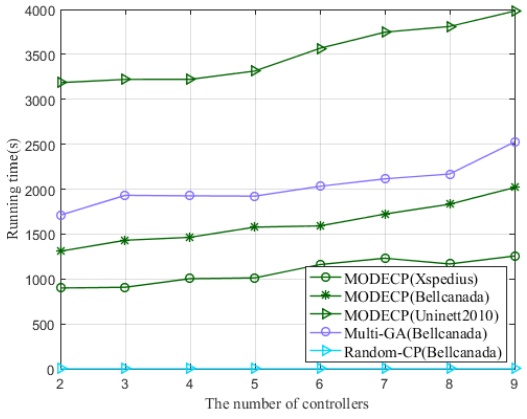
Figure 5. The running time of the algorithm .